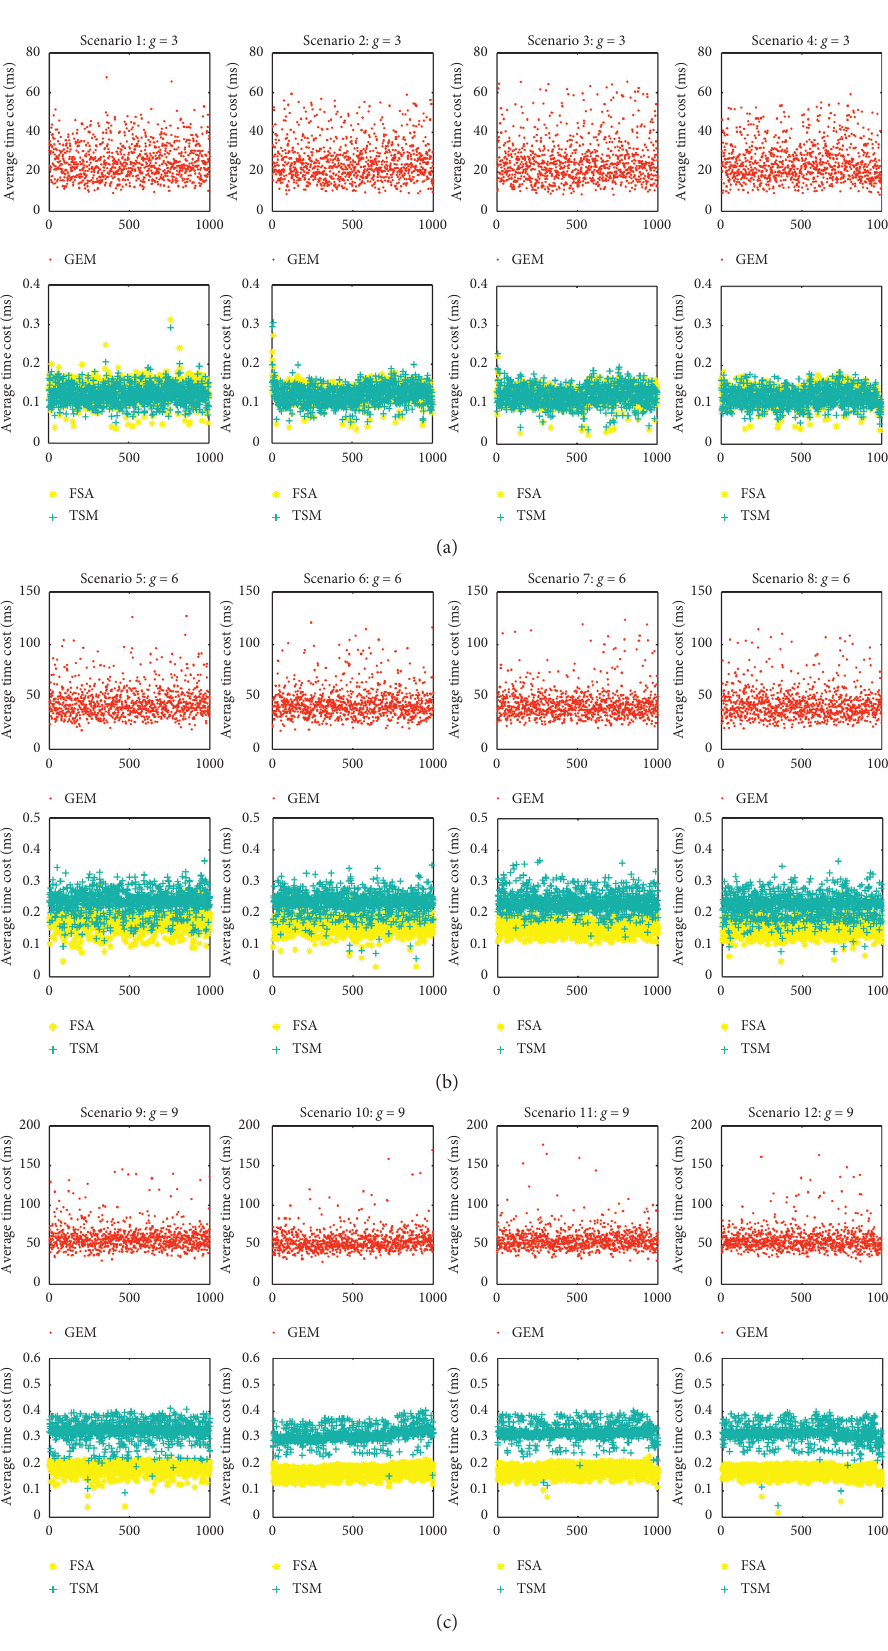
Figure 2: Time cost of algorithms for global MLEs from 1000 parameter